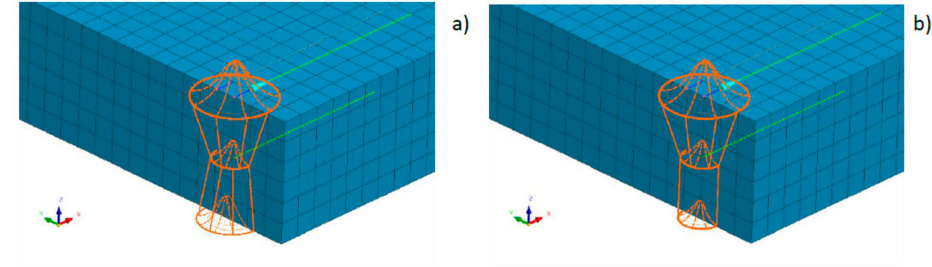
Figure 8. A view of heat sources models consisting of ( a ) two conical sources and ( b ) a conical and cylindrical source (green lines correspond to trajectories along which the sources move).